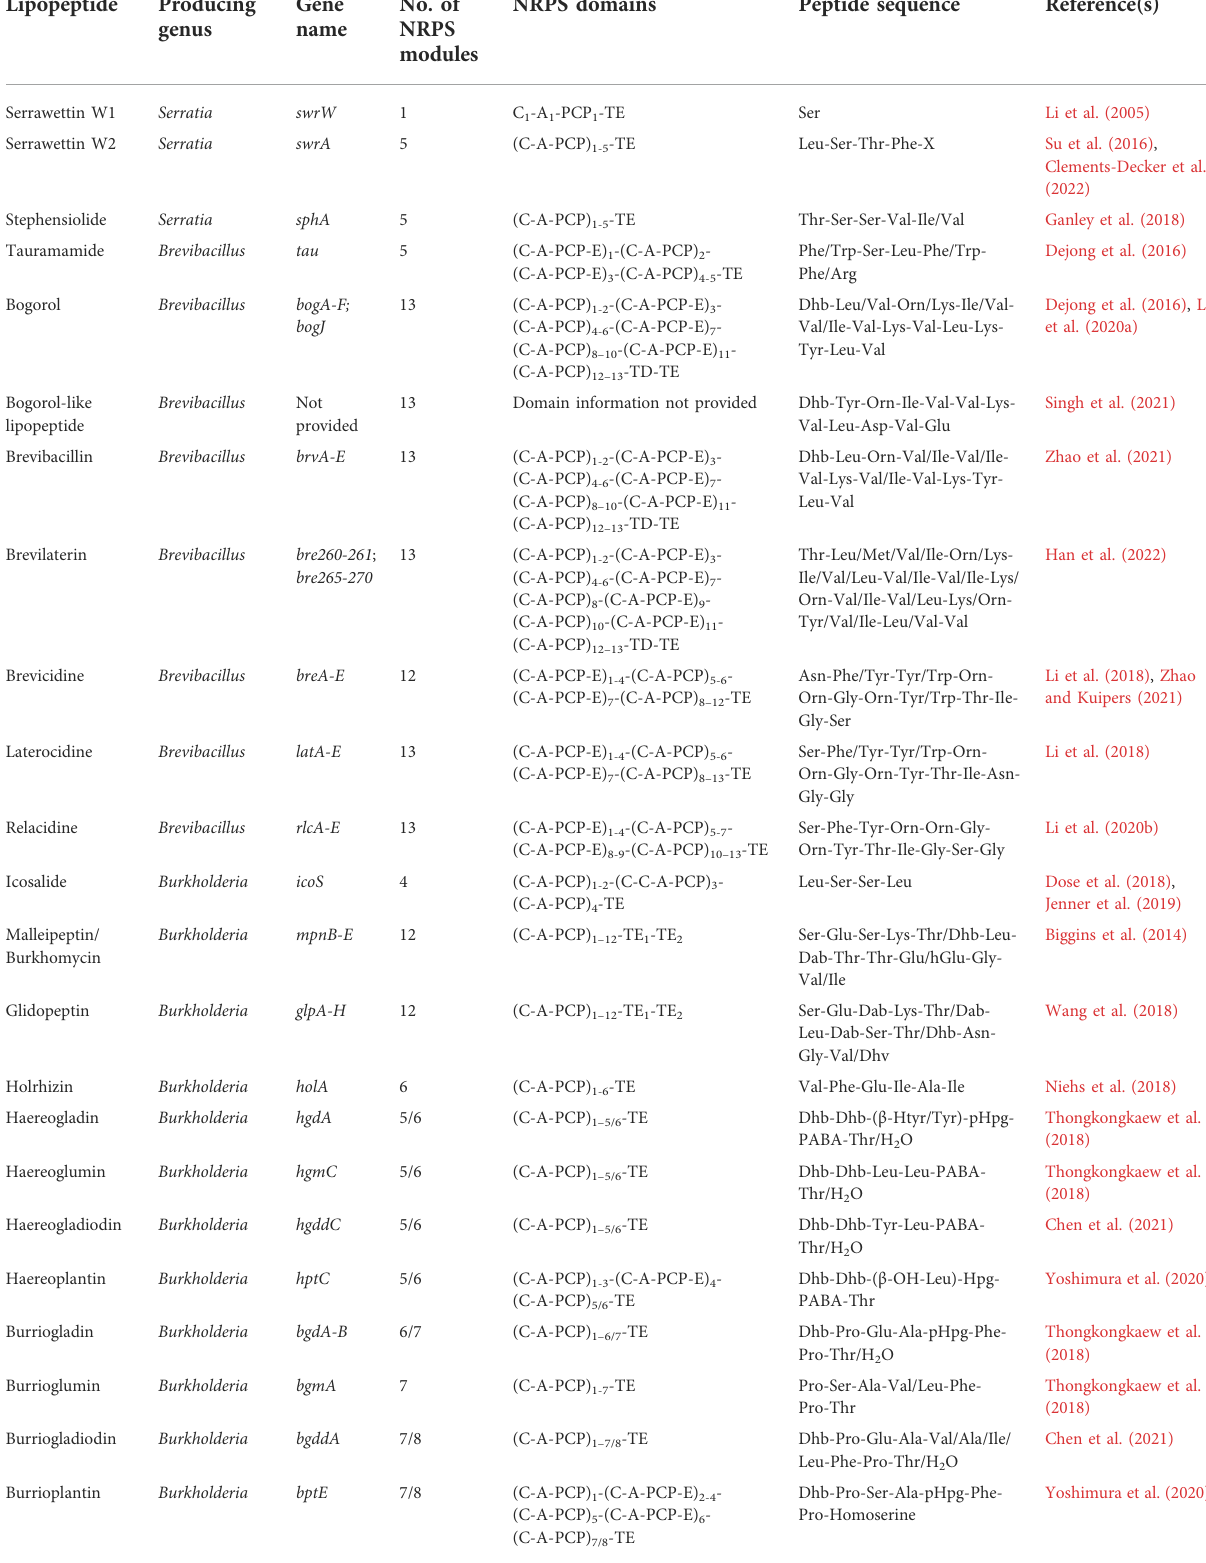
TABLE 1 Summary of the known PKS-NRPS BGCs identi fi ed from Serratia , Brevibacillus, and Burkholderia species.